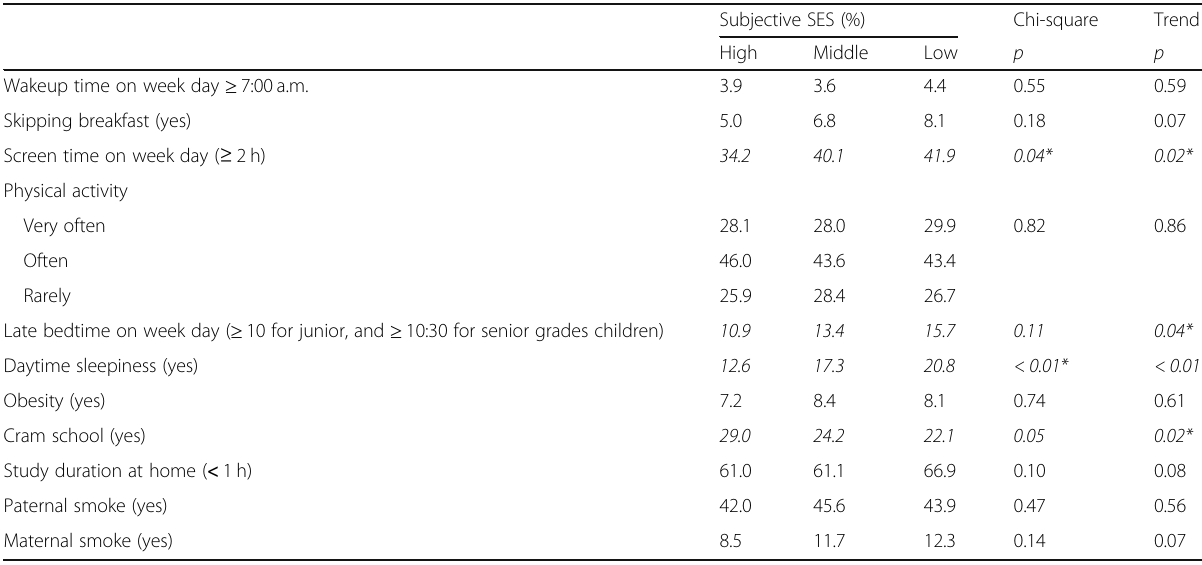
Table 4 Subjective SES and lifestyles n =